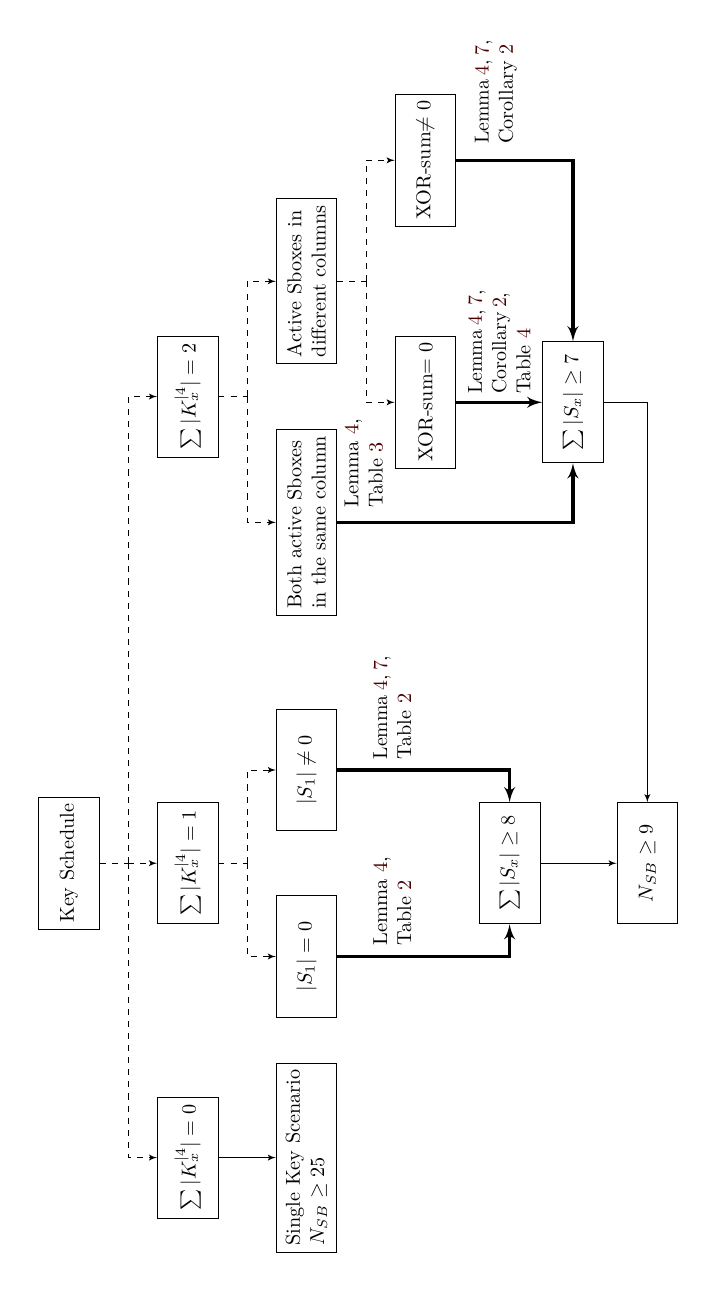
Figure 10: General structure of the proof in Section 5.3 that P | K | 4 x | < 3 implies N SB ≥ 9. A thick arrow represents a proven implication, a thin arrow represents a direct implication and hashed arrows represent subcases that are